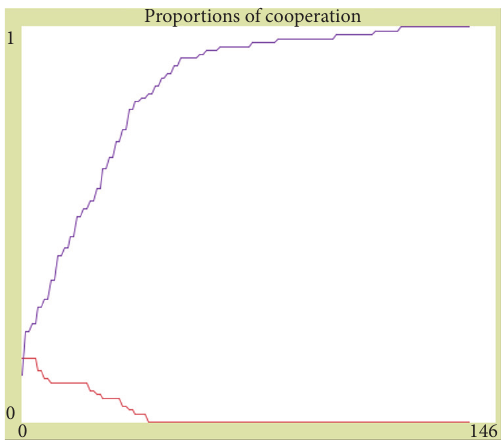
Figure 4: Influence of increasing frequencies of enterprise supervi- sion On CWB.